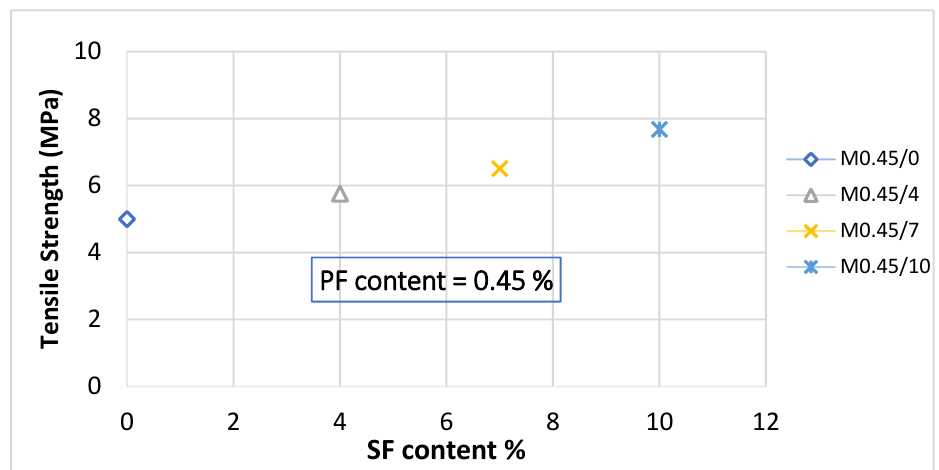
Figure 12. Effect of steel fiber content on tensile strength under ambient conditions.